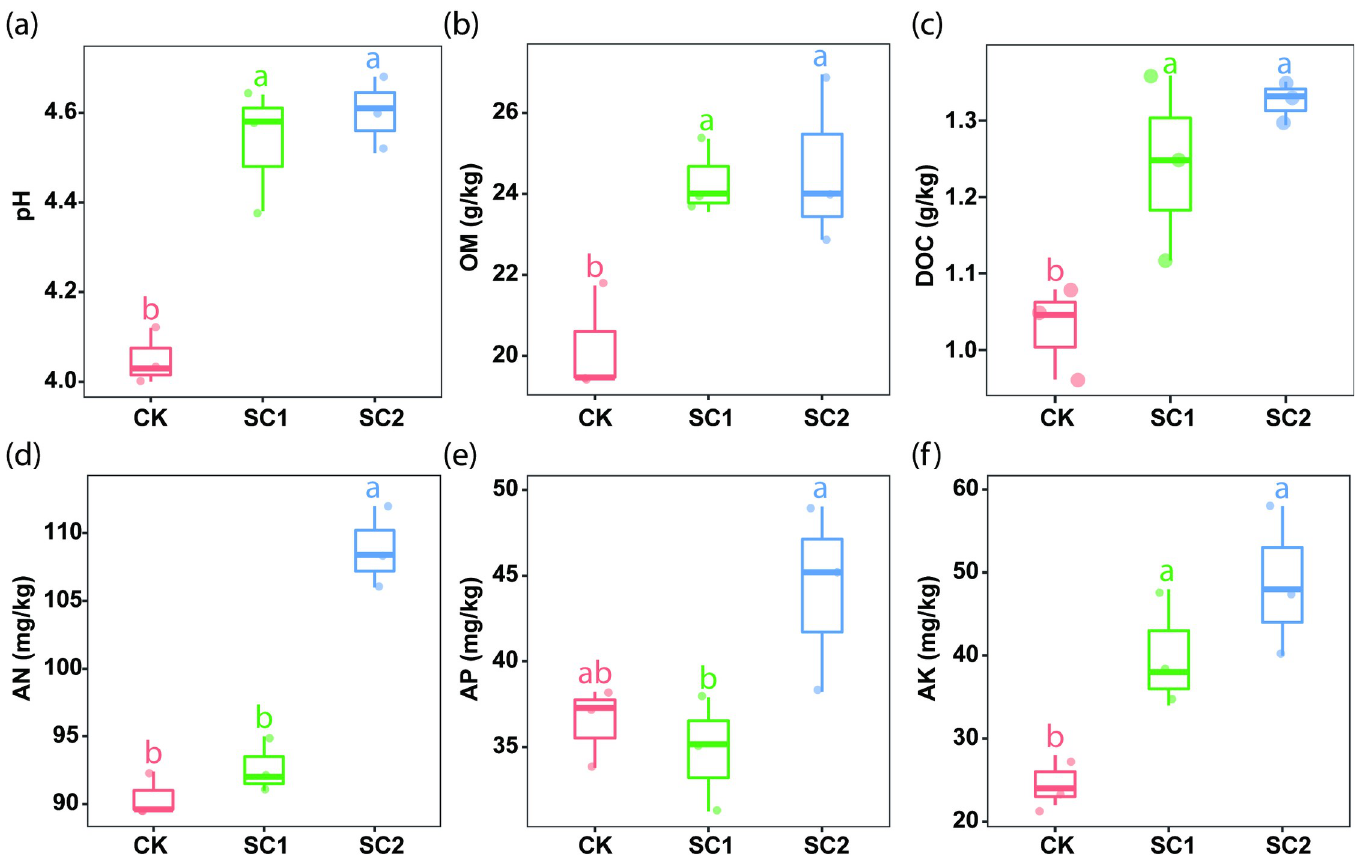
Fig 1. Box plot indicating the effect of water-soluble fertilizer application on soil physiochemical properties under sugarcane cultivation. Lowercase letters indicate the difference among treatments based on the LSD test (p < 0.05). AN, available nitrogen; AP, available phosphorus; AK, available potassium; OM, organic matter; DOC, dissolved organic carbon; CK: N, P, and K fertilizer; WS1: water soluble fertilizer 1,050 kg/hm 2 ; WS2: water soluble fertilizer 1,650 kg/hm 2